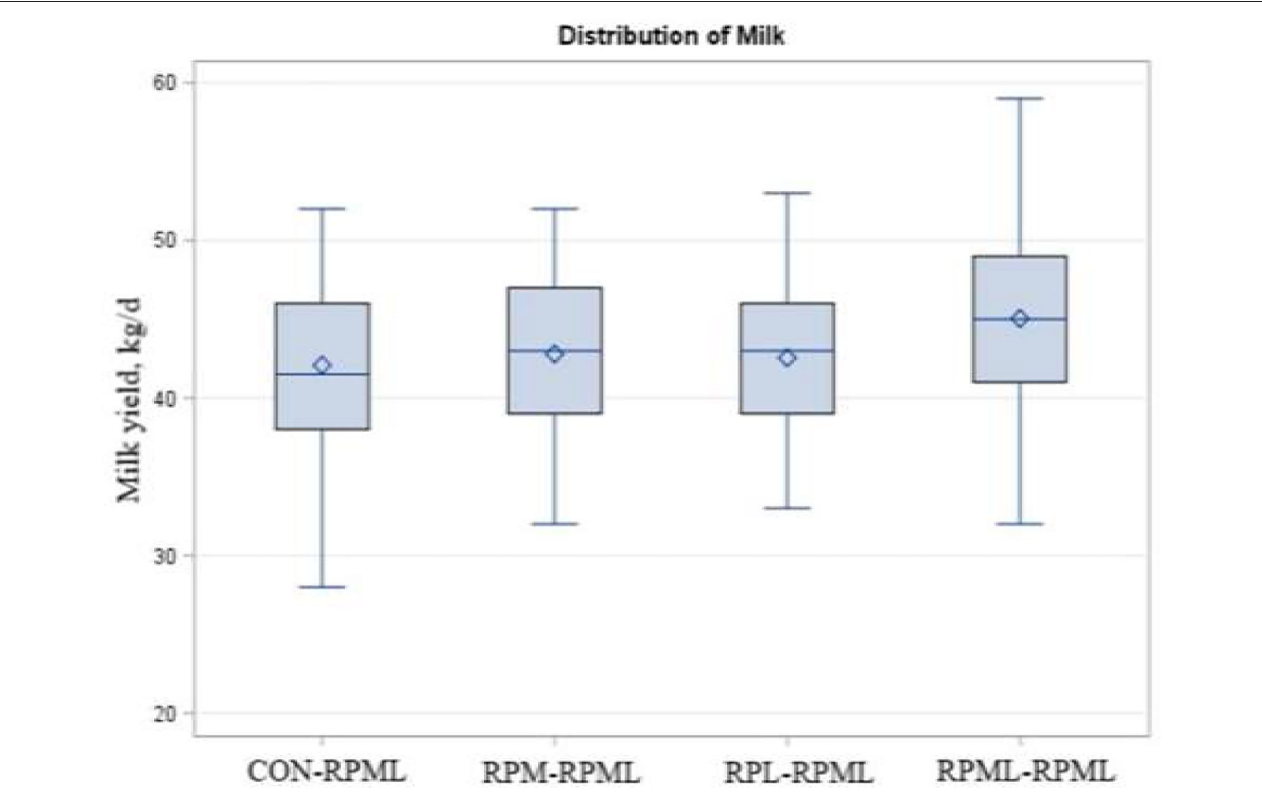
FIGURE 6 | Effect of supply ruminally protected Met and Lys to transition and milking dairy cows on milk yield. Values are means; standard errors are represented by vertical